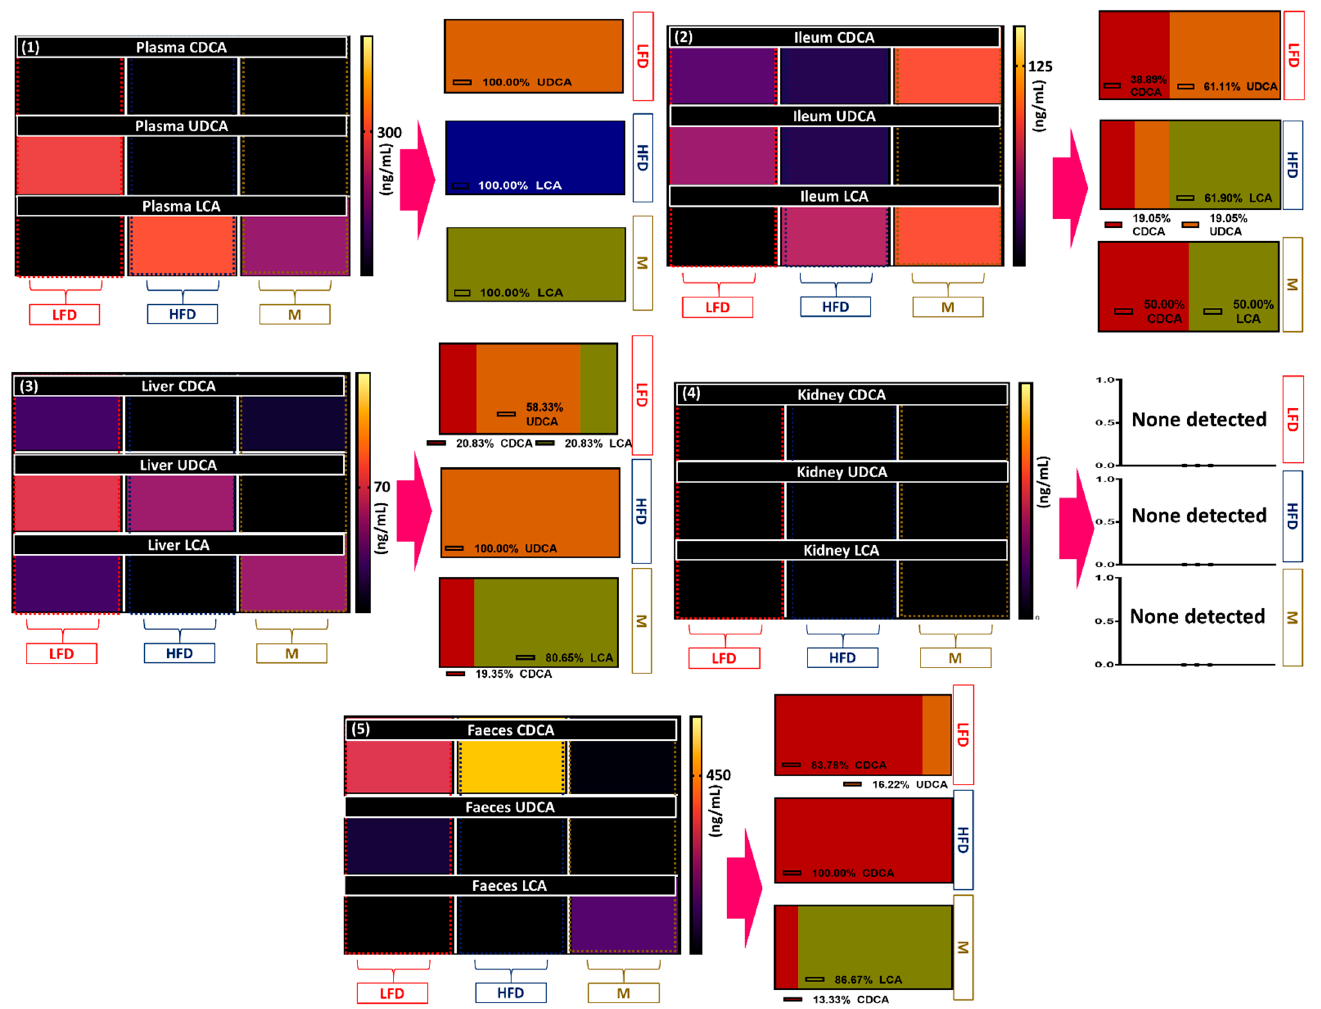
Figure 4. Levels of bile acids; chenodeoxycholic acid (CDCA), ursodeoxycholic acid (UDCA), and lithocholic acid (LCA) in the plasma ( 1 ), ileum ( 2 ), liver ( 3 ), kidney, ( 4 ), and faeces ( 5 ). HFD = high-fat diet, LFD = low-fat diet, M = metformin-treated. n = 8, mean values displayed.